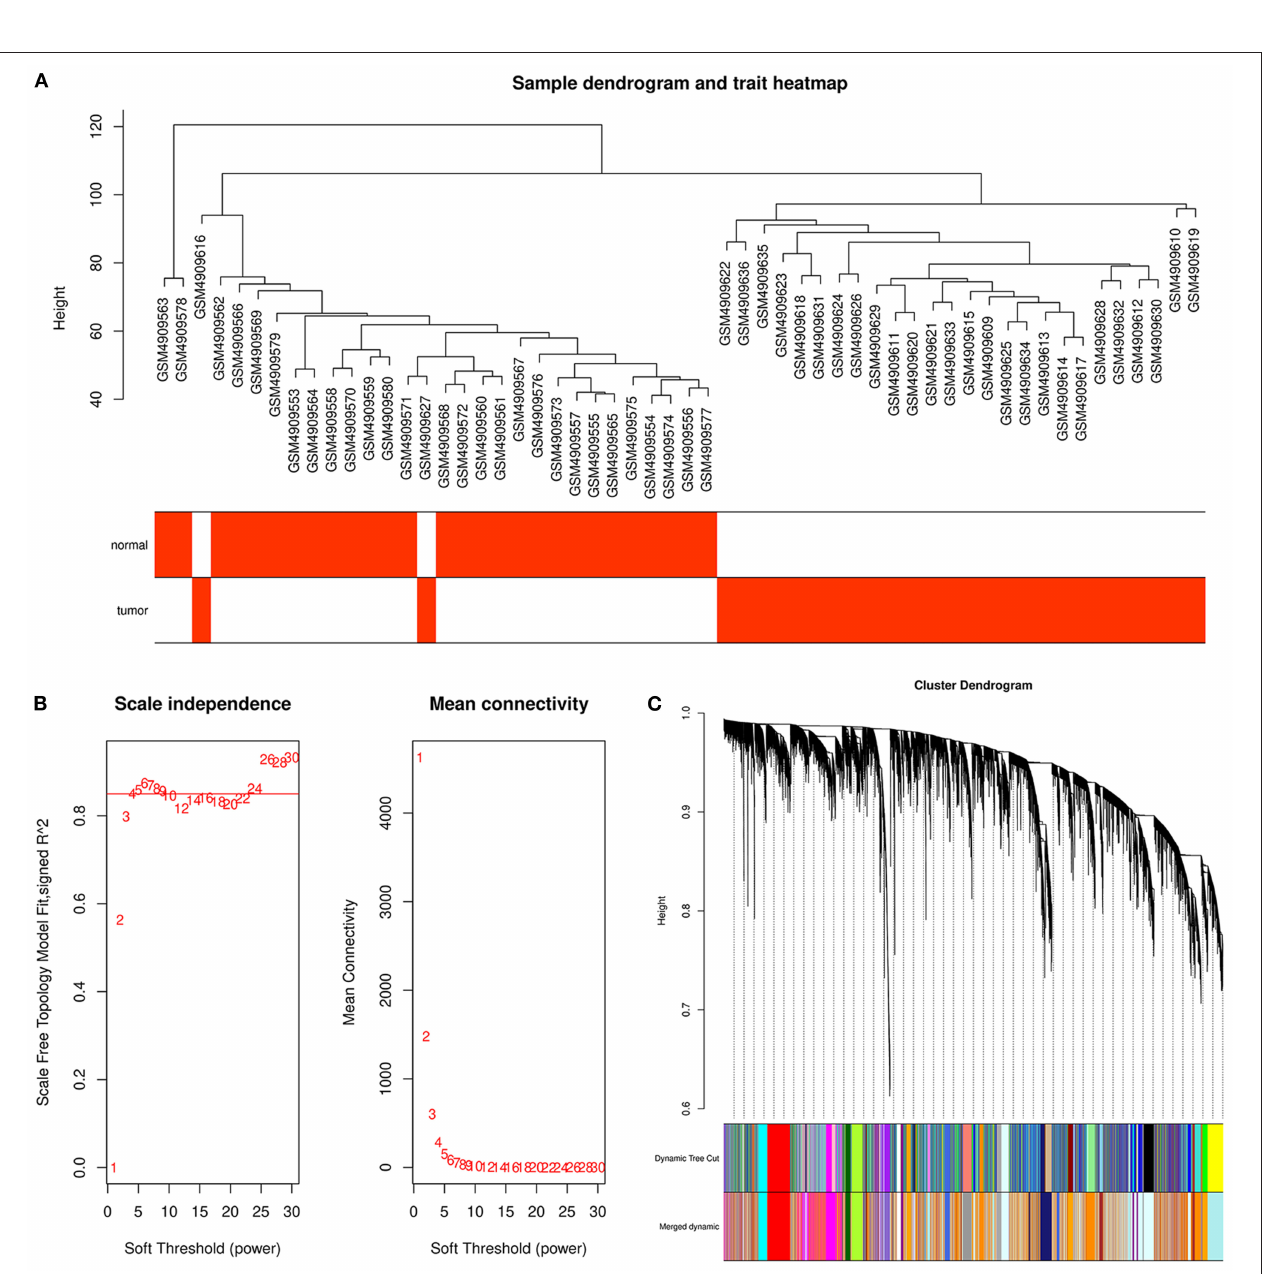
FIGURE 2 | Construction of the weighted gene co-expression network based on GSE161533. (A) Sample dendrogram and trait heatmap. Red or white bar codes underneath the dendrogram correspond to the presence or absence of a pair of mutually exclusive clinical traits. (B) Identification of soft-thresholding powers based on scale independence and mean connectivity. The minimum power that satisfied a scale-free fit index of 0.8 was selected. (C) Module identification using dynamic tree cut. The minimum module size was 30. Modules with the top 25% similarity were merged.